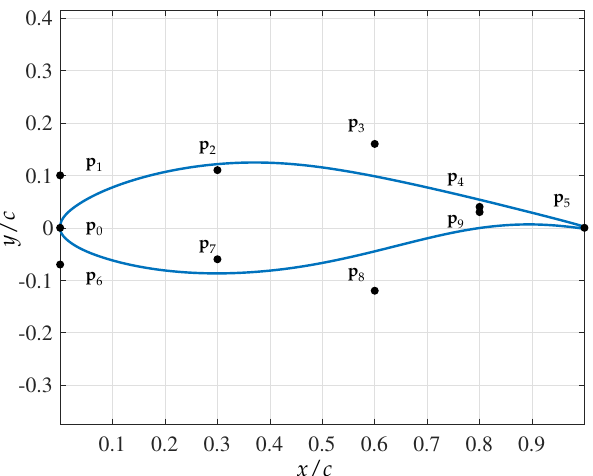
Figure 1. The baseline wind turbine airfoil with the control points of the Bezier